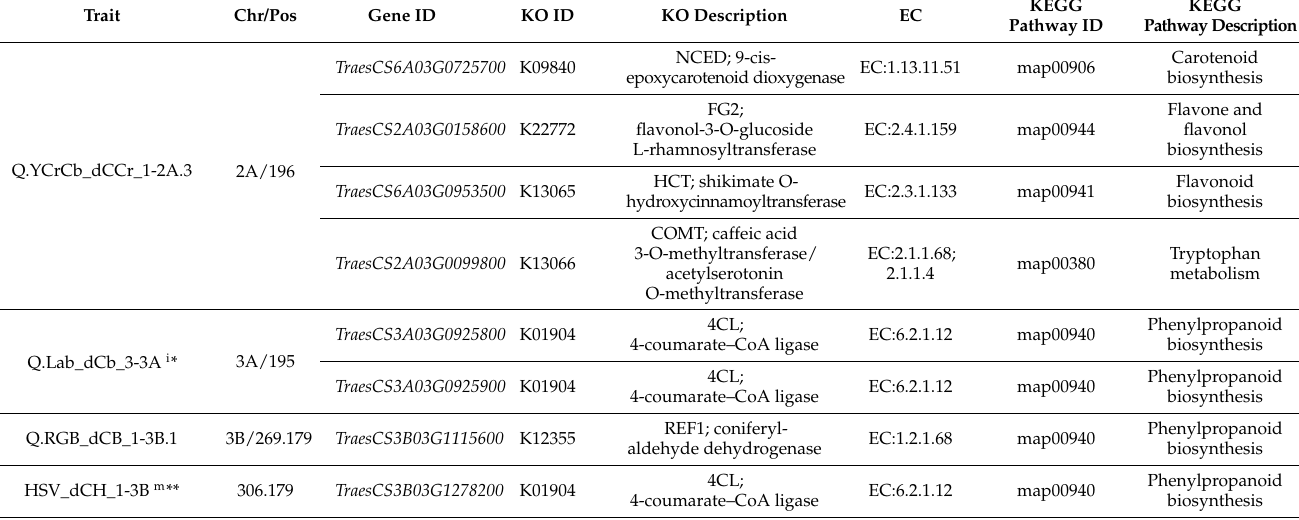
Table 2. List of candidate genes from QTLs associated with seed shell color. Columns of the table contain QTL name (QTL), chromosome and position in cm (Chr/Pos), gene ID, KEGG orthogroup ID, KEGG orthogroup description, EC number, KEGG pathway ID and